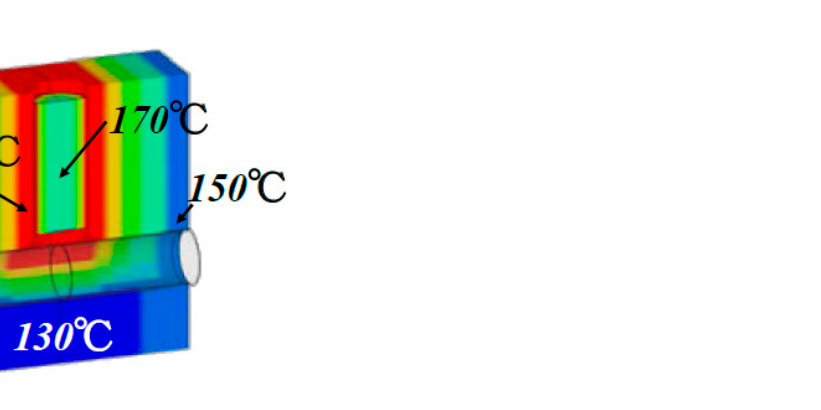
( b ) Figure 16. Effect of T bottom on RMS of wall thickness distribution along the bottom part. ( a ) The t RMS ; ( b ) wrinkles occurred at bulging head.